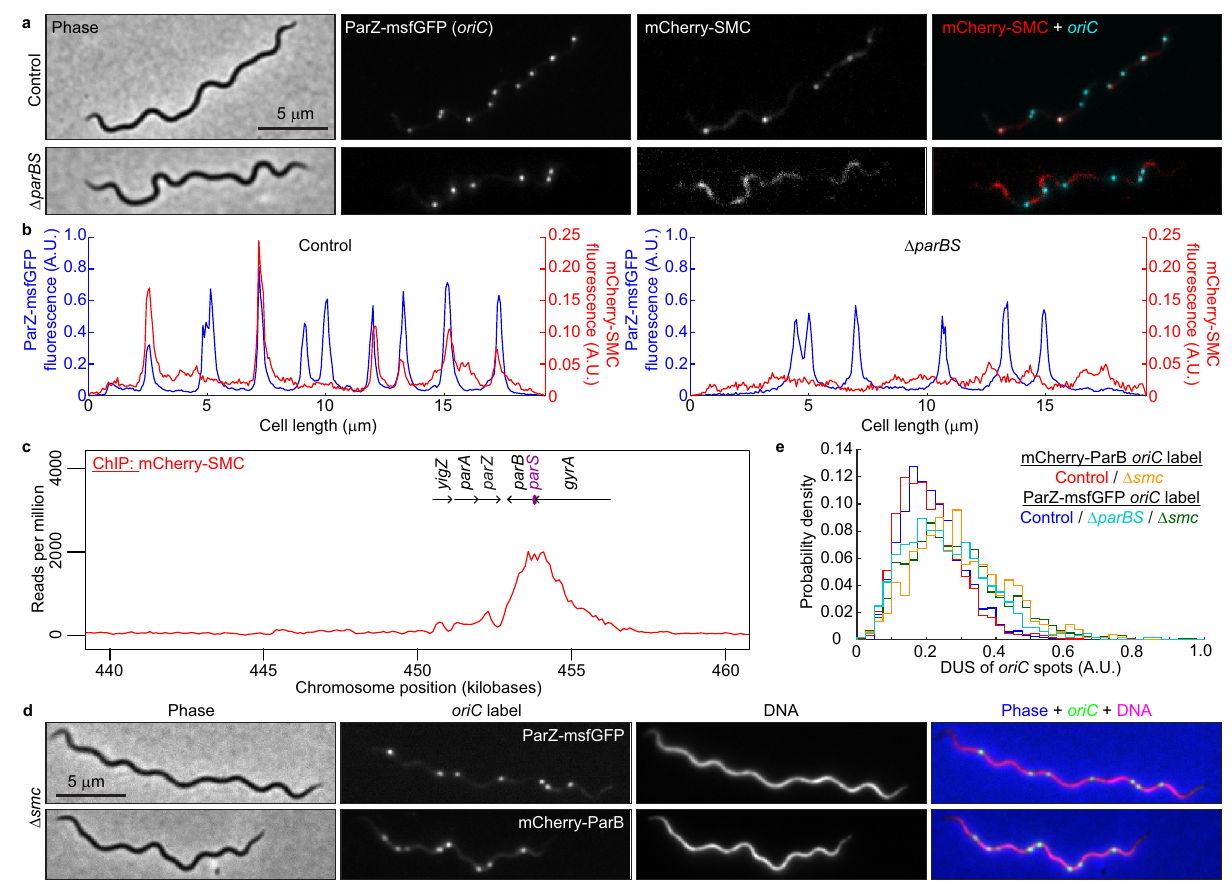
Fig. 9 | SMC is recruited to the oriC region by ParB and mildly contributes to regular oriC spacing. a Images of cellsexpressing ParZ-msfGFP (to label oriC ) and mCherry-SMC in control (CJW_Bb602, carrying the full complement of par genes) and Δ parBS (CJW_Bb615) strains. b Fluorescence intensity pro fi les along the cell lengthforthecellsshownin( a ). c ChIP-seqpro fi leshowingthebindingofmCherry- SMC to the par locus in strain CJW_Bb601. Genes underlining the enriched sequencereadsarehighlighted. d Imagesofcellsshowing oriC localizationin Δ smc strains in which the oriC is labeled with either ParZ-msfGFP (CJW_Bb603) or